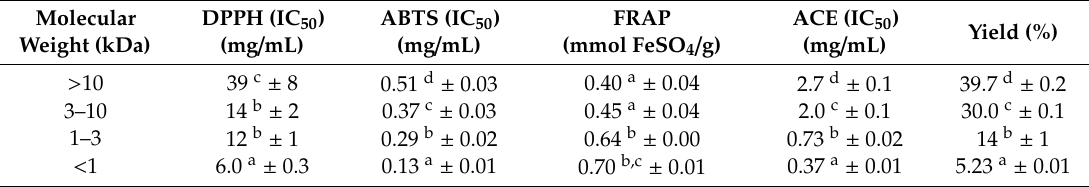
Table 5. Molecular weight distribution of TB hydrolysate using membrane fractionation.